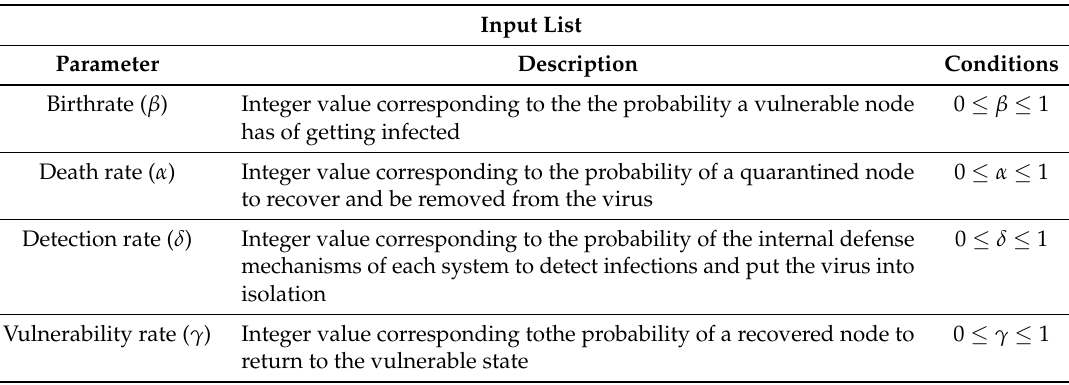
Table 4. Attack model parameters